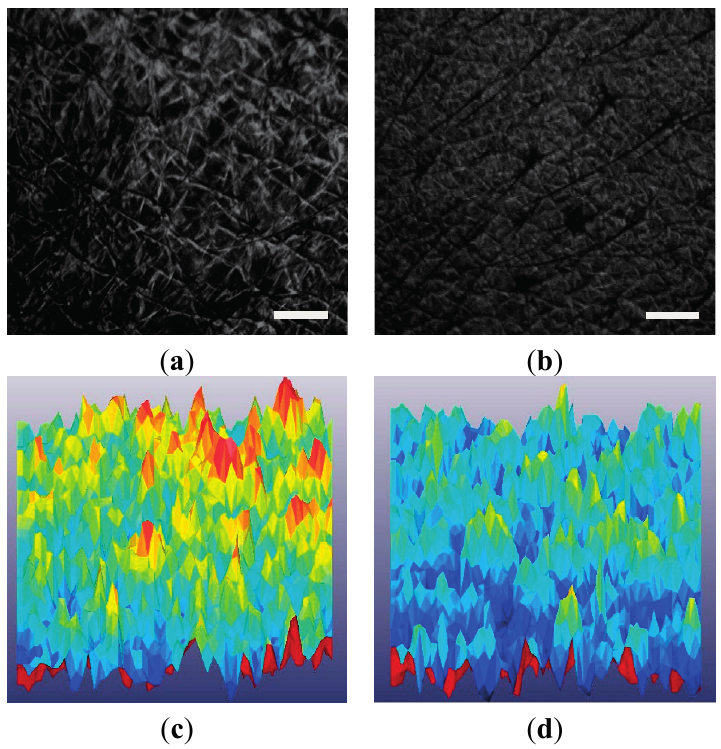
Figure 4. Visioscan ® VC98 UV camera images obtained ( a ) before any treatment; ( b ) after 90 days’ treatment with Cassia fistula extract emulsion; Scale bar: 1 mm for (a) and (b); ( c ) 3D image before any treatment; ( d ) 3D image after 90 days treatment. The yellow and red color in (c) indicate extensive roughness (SEr), scaliness (SEsc) and wrinkles (SEw) while light yellow color in (d) shows decrease roughness and improved skin smoothness